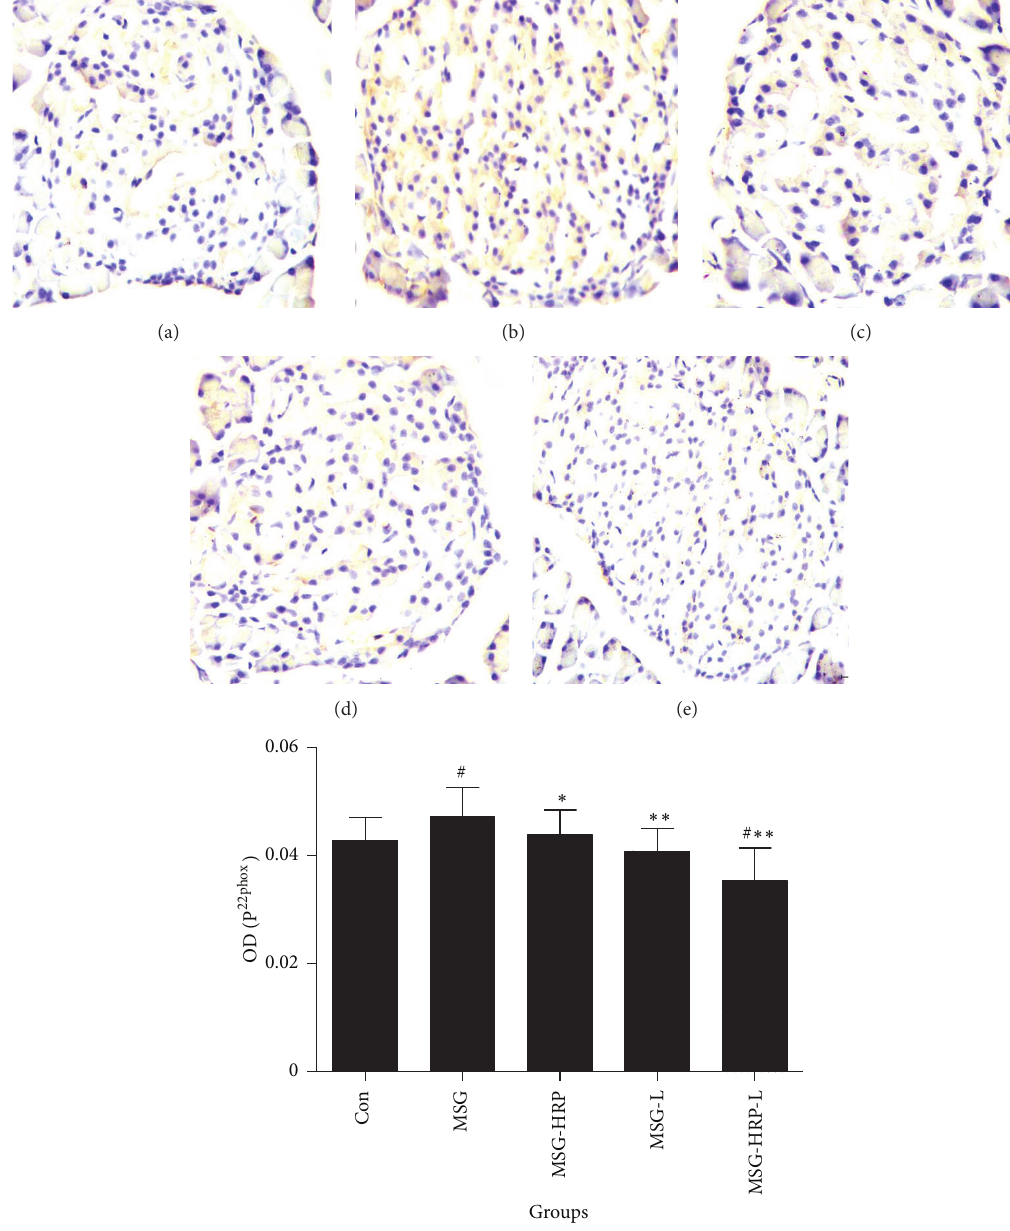
increased in MSG rats when compared with the control group. Treatment with losatan, HRP, and both decreased the NADPH oxidase activity in pancreatic tissue (compared with MSG group, 𝑃 values were all < 0.01). Increased NADPH oxidase activity was strongly correlated with levels of local Ang-II in pancreatic tissues ( 𝑟 = 0.665 , 𝑃 < 0.01